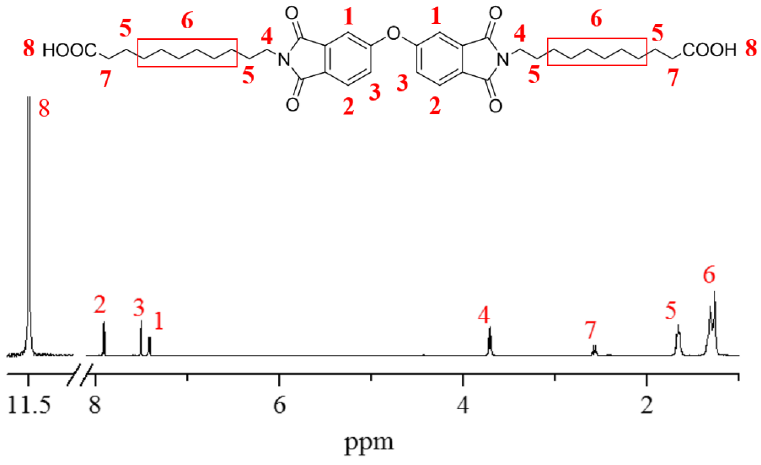
Figure 2. H-NMR spectrum of diimide diacid monomer.